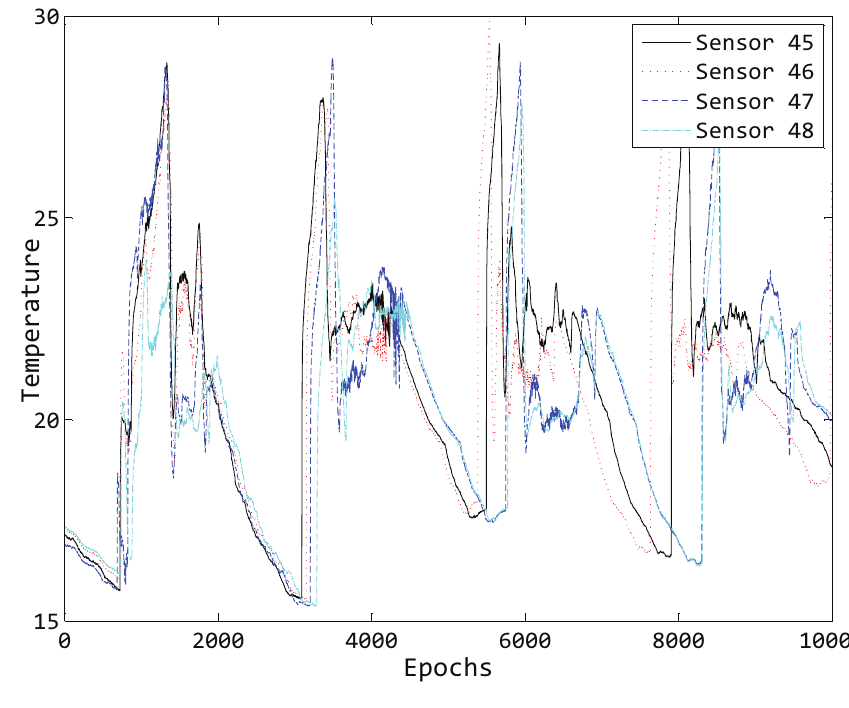
Figure 7. Ten thousand epochs’ temperature of four different sensor